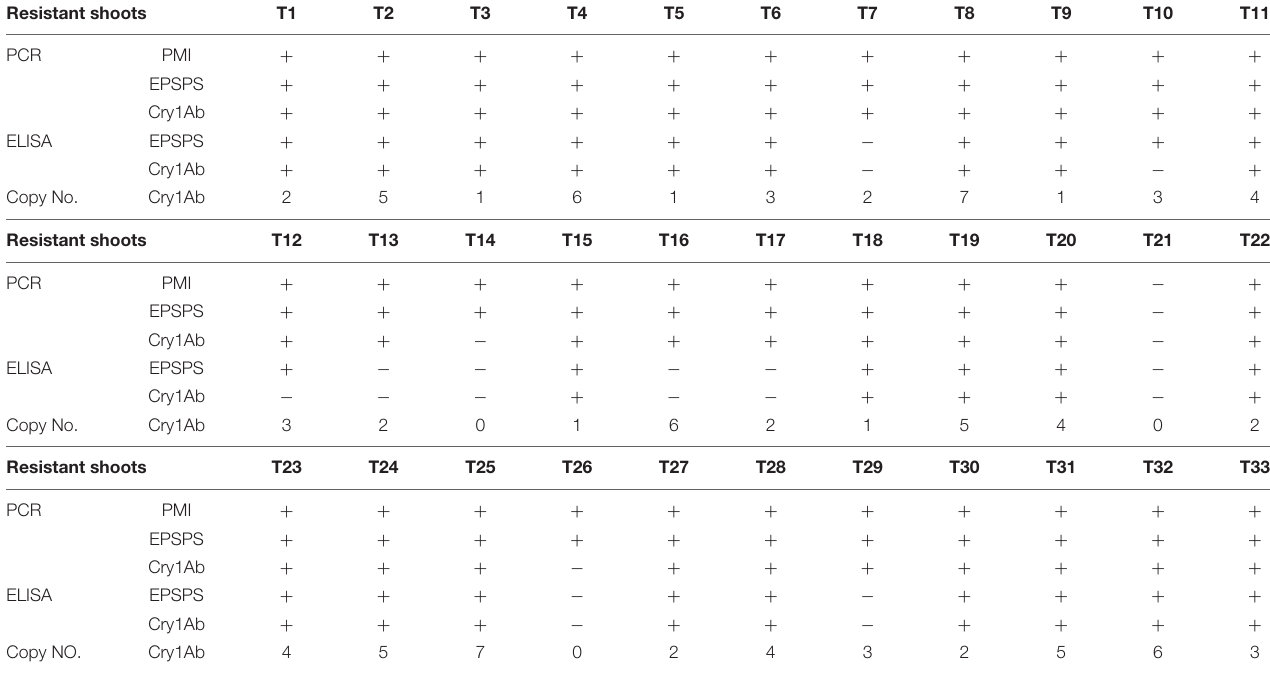
TABLE 2 | PCR, Southern blot, and ELISA